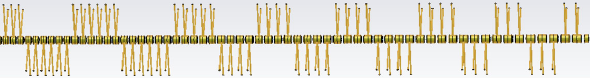
FIG. 16. Stem configuration E determined through tuning the frequency of the basic TE -mode. The increase of the cell length leads to a decrease of the stem density and m decreases